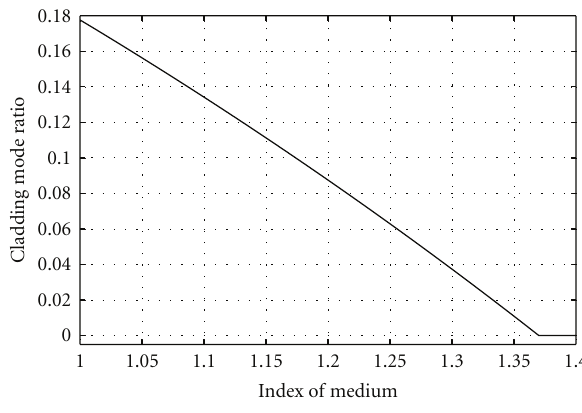
Figure 3: Cladding mode ratio versus medium index.